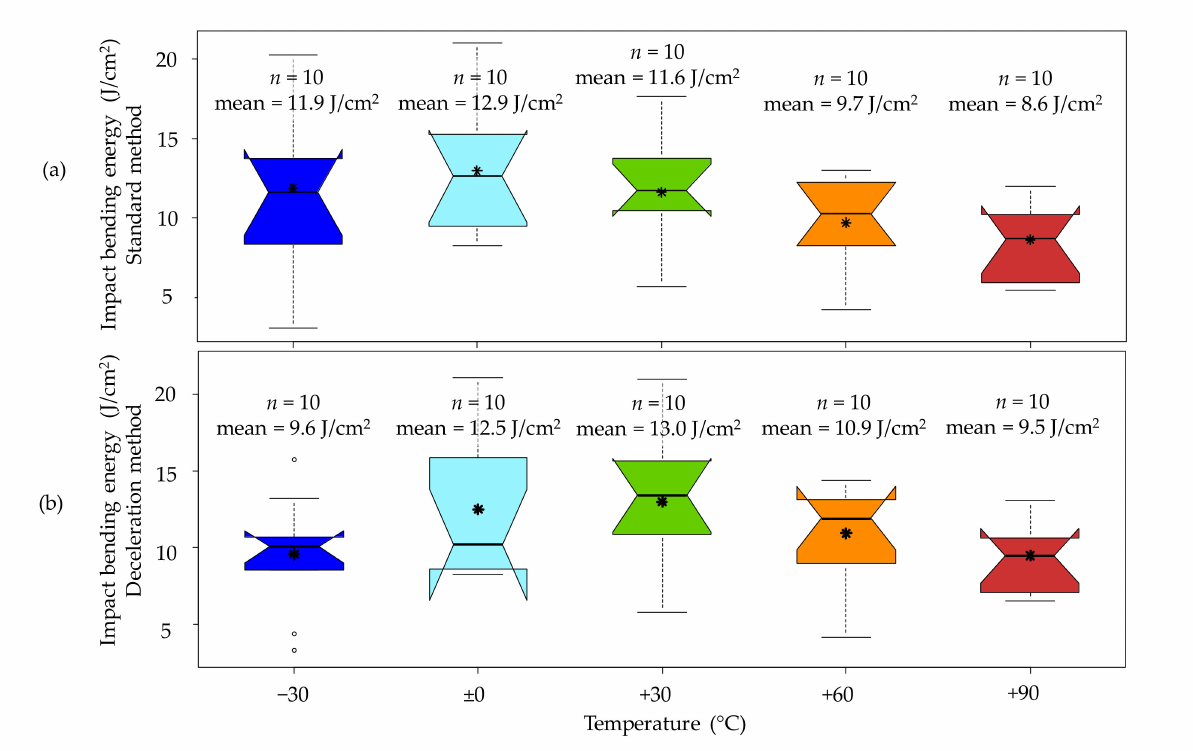
Figure 5. Boxplots of the impact bending energy of beech by temperature level, with the standard method ( a ) and with the deceleration method ( b ). * An interpretation aid concerning the boxplots can be found in Appendix A, Figure A1.